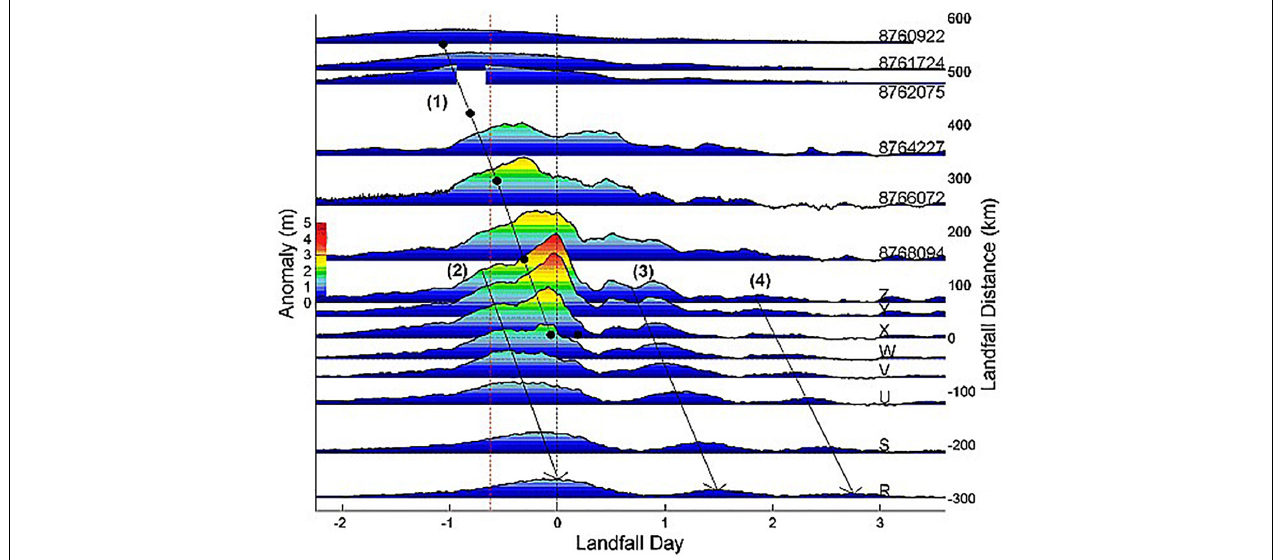
FIGURE 8 | Observed time series of water level anomaly during Hurricane Ike (2008) along the open coasts of Louisiana and Texas (top-to-bottom show easternmost locations to westernmost locations). Data shown include rapidly installed pressure sensors (R-Z) by A. Kennedy (University of Notre Dame) and